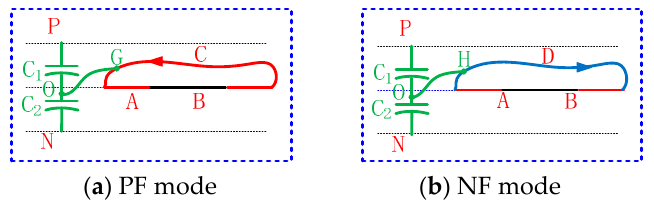
Figure 3. Indirect Connection of Unified NPC cell under USPWM. ( a ) PF mode; ( b ) NF mode.